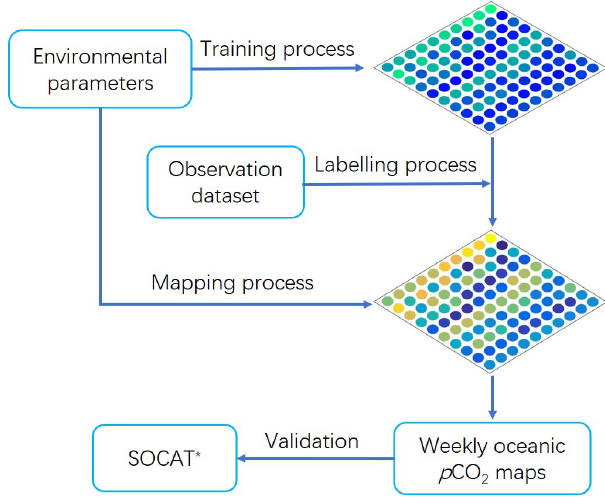
Figure 3. Schematic diagram of the main three steps involved in the SOM neural network calculations used to obtain weekly p CO 2 maps for February to early March